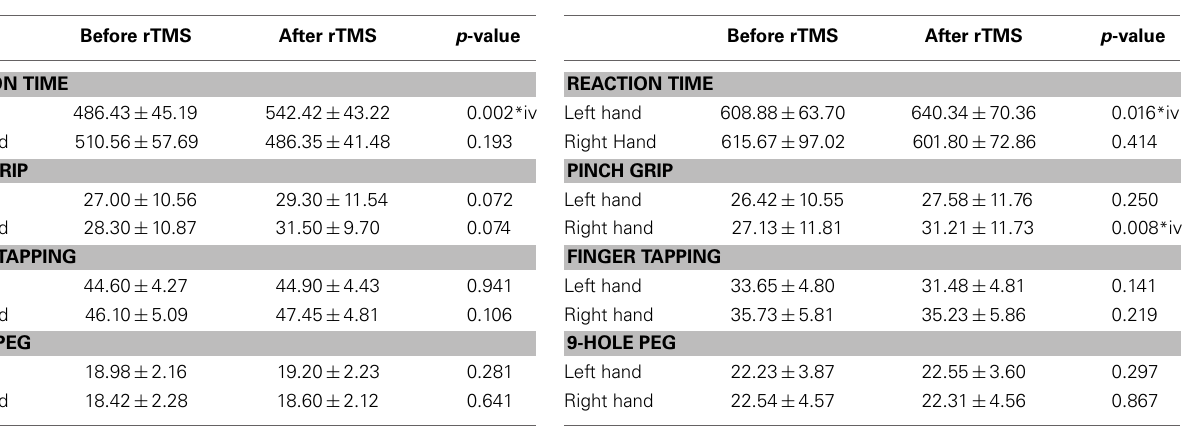
Table 3 | Pre- and Post-rRMS comparisons of behavioral data for younger subjects.